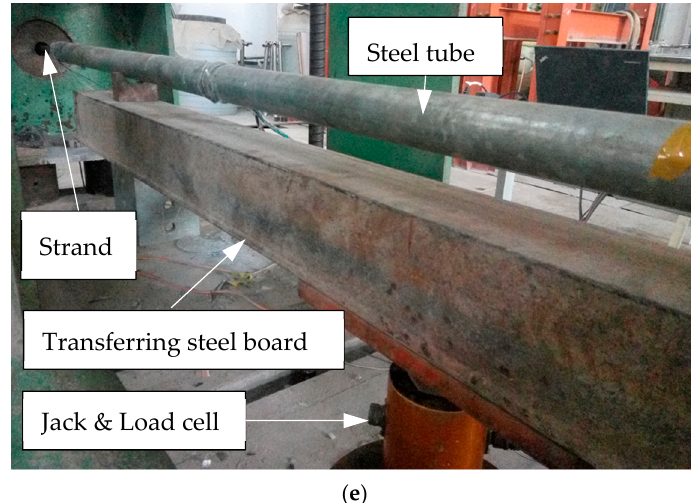
Figure 7. The sketches and photographs of the test design: ( a ) applying tensioning to the bare strand; ( b ) applying load on the cement-filled steel tube; ( c ) the photograph of the strand attached with sensor; ( d ) the photograph of tensioning and ( e ) the photograph of vertical load applied on the cement-filled steel tube.